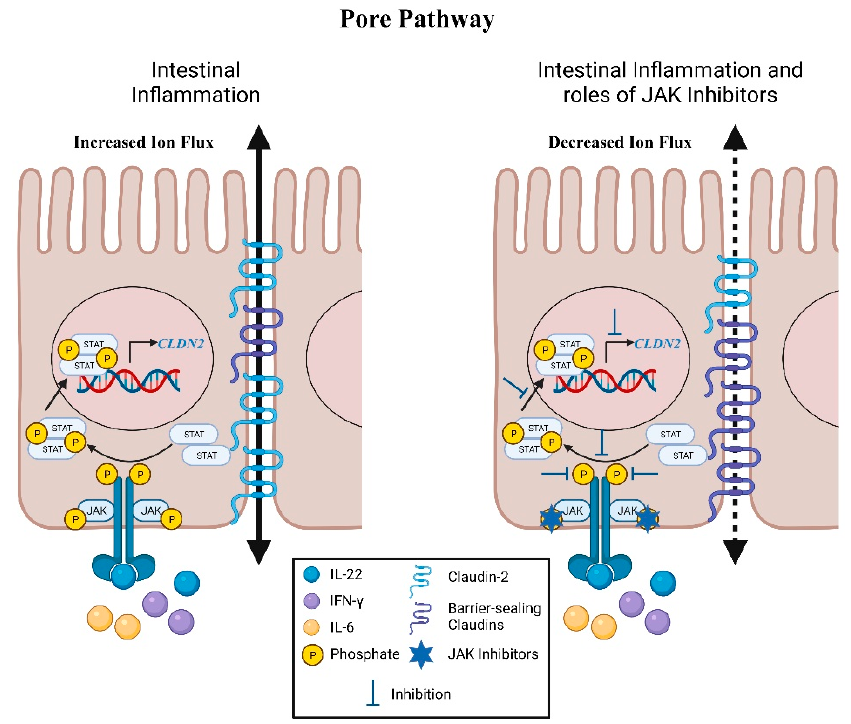
Figure 2. JAK-STAT regulation of intestinal permeability: Pore Pathway. During intestinal inflammation, proinflammatory cytokines are released and bind to their respective receptors on intestinal epithelial cells. The associated cellular tyrosine kinases, JAKs, are then brought together and activated. These interactions subsequently lead to phosphorylation of the cytokine receptor which act as hubs for STATs. The JAKs would then phosphorylate the STATS and the phosphorylated STATs would dimerize, enter the nucleus, and serve as transcription factors for genes that express tight junction proteins which influence intestinal permeability. In the pore pathway, claudin-2 expression is upregulated in response to IL-22, IFN- γ , and IL-6. Expression of barrier-sealing claudins is reduced; however, the mechanisms that underlie these alterations require further investigation. The JAK inhibitors tofacitinib, AZD1480, and JAK inhibitor I, reduce expression of claudin-2 and consequent paracellular permeability via the pore pathway. Downregulation of claudin-2 expression has also been reported with STAT1 and STAT3 siRNA intervention. Levels of barrier-sealing claudins are suggested to return to normal levels during remission of inflammation. These illustrations were made using BioRender. ( CLDN2 : Claudin-2 Gene, JAK: Janus Kinase, STAT: Signal Transducer and Activator of Transcription).